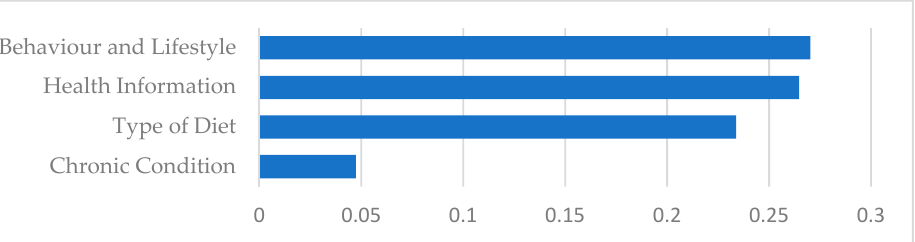
Figure 5. Average weight of categories per tweet.